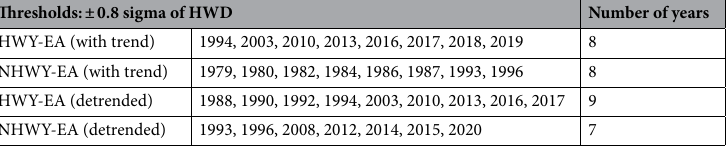
to 2.56 (after the 2000s). An increasing standard deviation after the 2000s implies that more extreme heat wave events have occurred in East Asia. In this study, we classified the heatwave years (HWY-EA) and non-heatwave years (NHWY-EA) based on the threshold of ± 0.8 sigma of the raw HWD and the detrended HWD in EA (Table 1). Most of the HWY-EA (with a trend) occurred after the 2000s, except for 1994. However, the HWY-EA